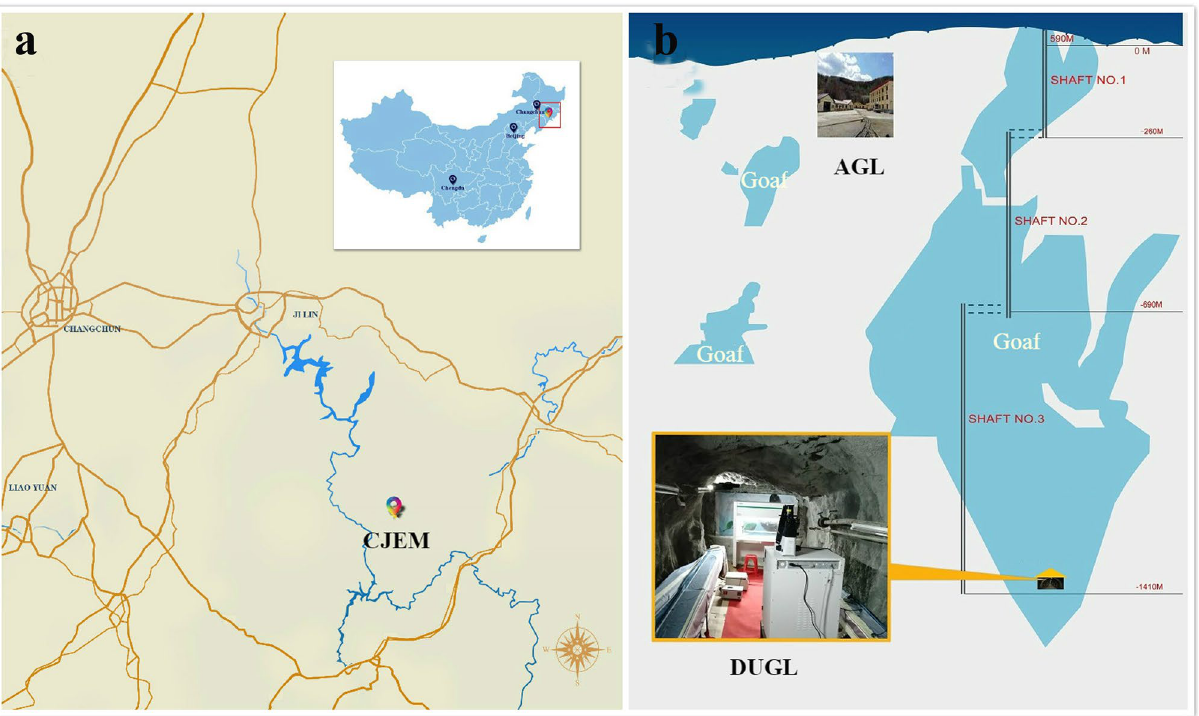
Figure 1. The location of the DUGL and the AGL at the CJEM. The location of the CJEM in China ( a ), and the location of the DUGL and the AGL in the CJEM ( b ). AGL, above-ground laboratory; CJEM, Erdaogou Mine, Jiapigou Minerals Limited Corporation of China National Gold Group Corporation; DUGL, deep-underground laboratory.(Adobe Photoshop CS3 was used creating ( a ), the URL is https ://downl oad.zol.com.cn/detai l/35/34736 1.shtml